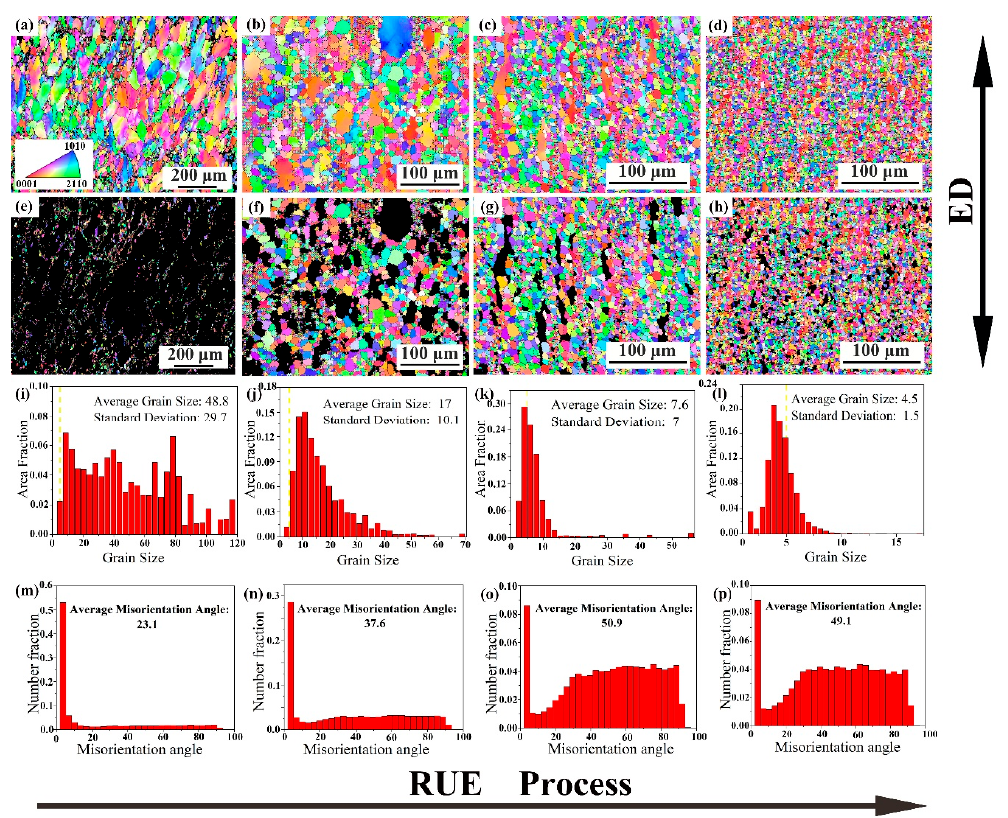
Figure 6. Grain orientation map ( a – d ); DRX grain orientation map ( e – h ); Grain size ( i – l ) and Misorientation distribution map ( m – p ). (SEM-EBSD) of the sample deformed in different passes at